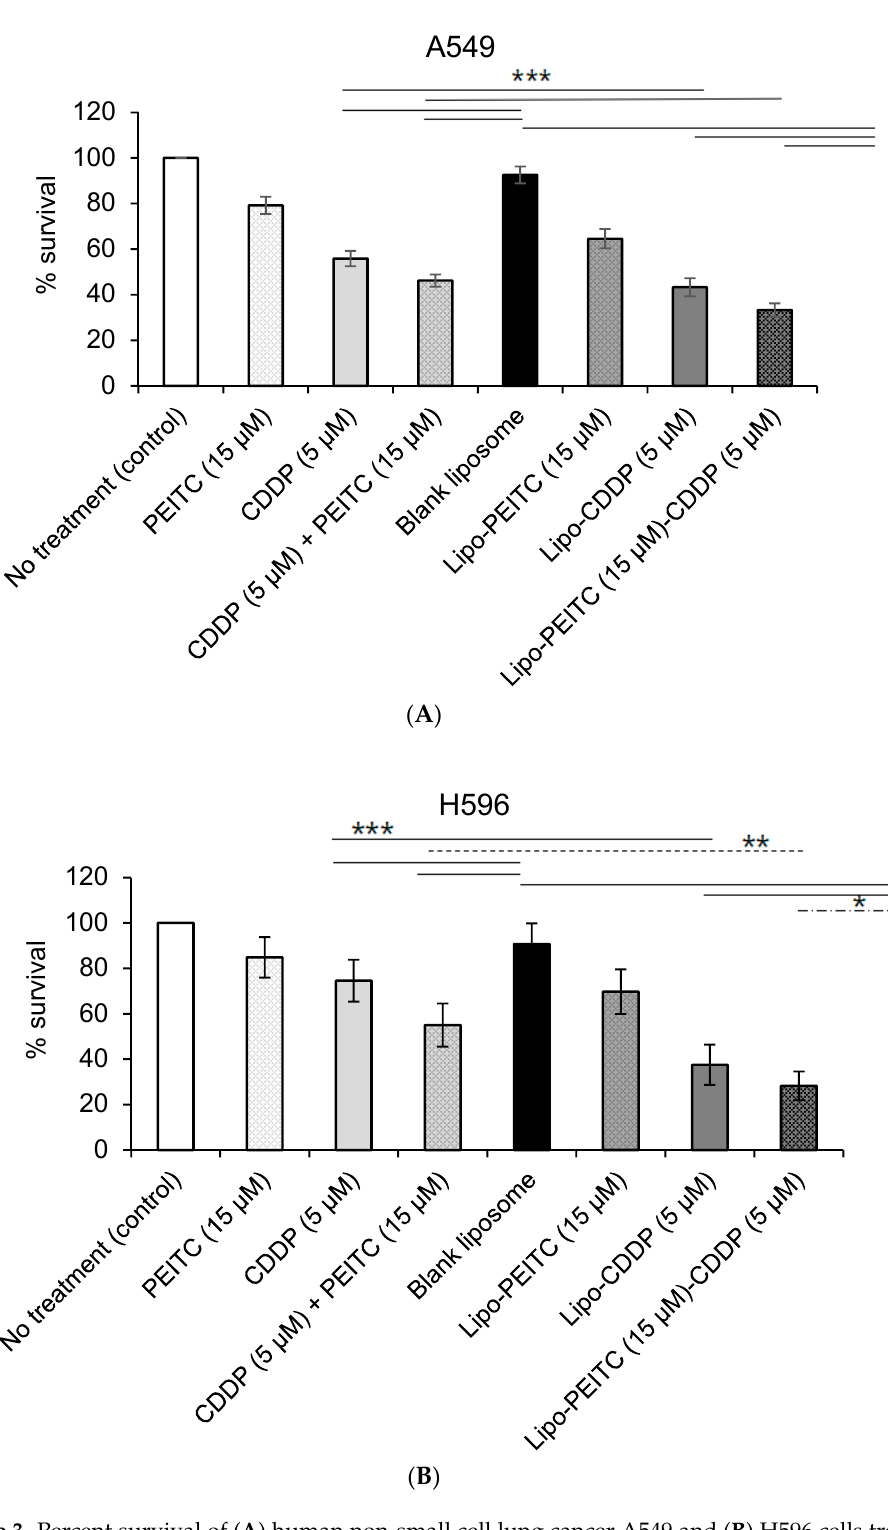
Figure 3. Percent survival of ( A ) human non-small cell lung cancer A549 and ( B ) H596 cells treated with free cisplatin (CDDP) and/or phenethyl isothiocyanate (PEITC), and liposome encapsulated compounds (solid line stands for *** p < 0.005, dash line stands for ** p < 0.01 and long dash dot line stands for * p < 0.05).